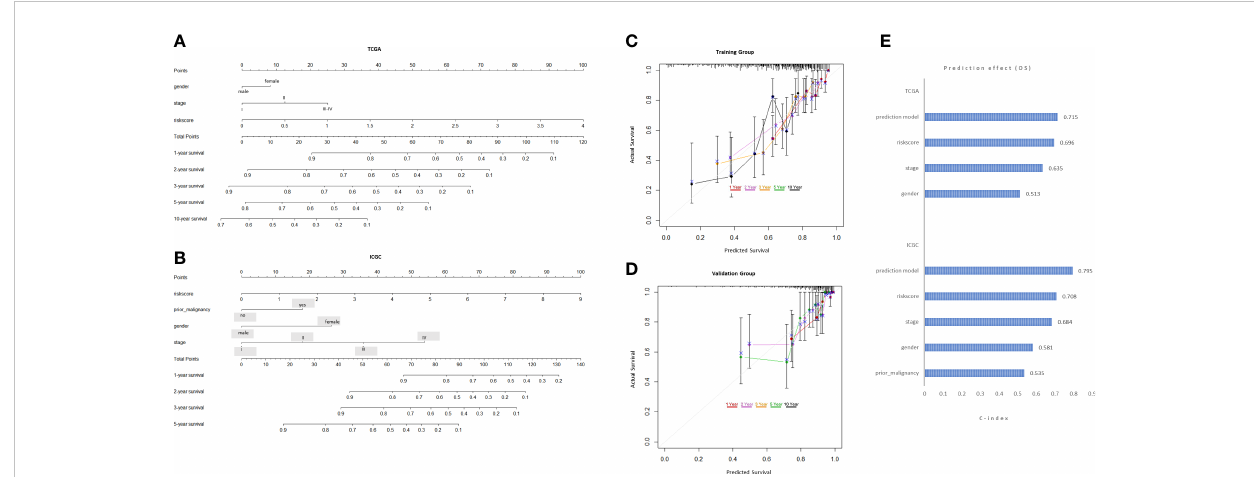
FIGURE 4 Development and validation of the predictive nomogram. (A, B) The nomogram construction based on the TCGA cohort and ICGC cohort. (C, D) The Calibration plot of the nomogram in training and validation groups. (E) C-index values of the nomogram.